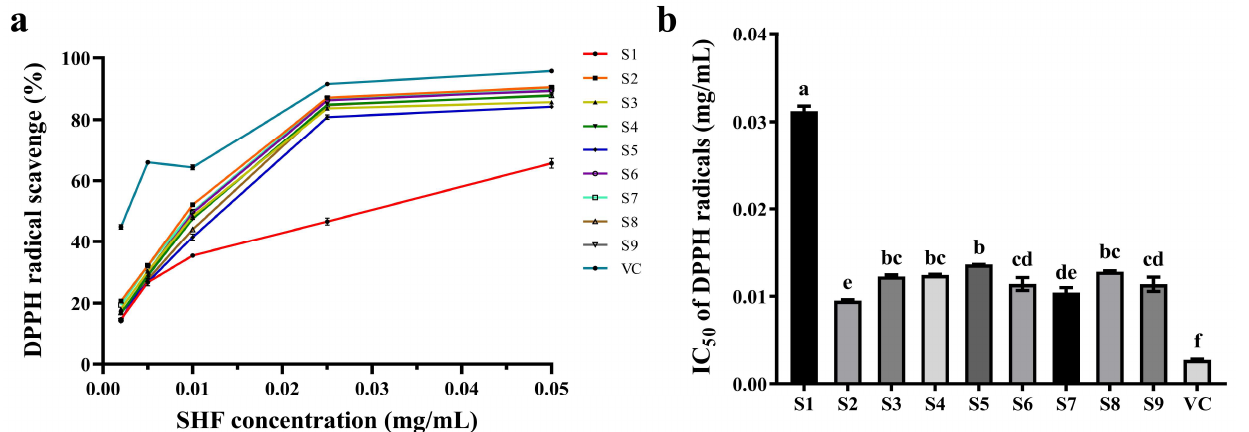
Figure 4. DPPH radical scavenging abilities of nine SHFs: ( a ) DPPH radical scavenging abilities of nine SHFs within concentration range 0.002–0.05 mg/mL; and ( b ) IC 50 for DPPH radicals. Differing letters above bars indicate significant ( p < 0.05) differences according to Tukey’s multiple comparisons test.